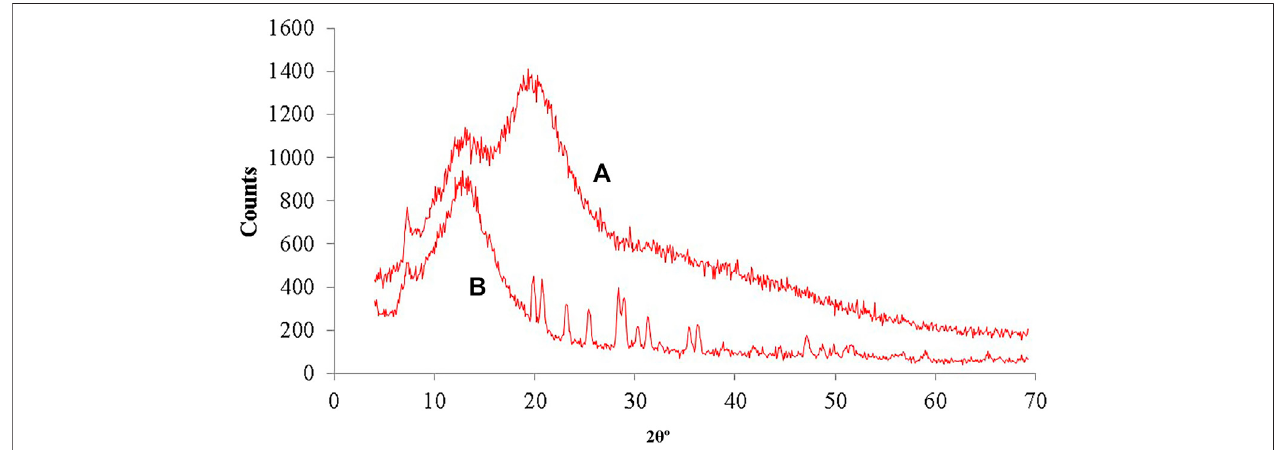
FIGURE 6 | (A) XRD diffractogram showing amorphous type nature of Hemicellulose, with various peeks between 20 ° – 50 ° in XRD of (B) Thiolated hemicellulose indicating change in the nature from amorphous to crystalline.